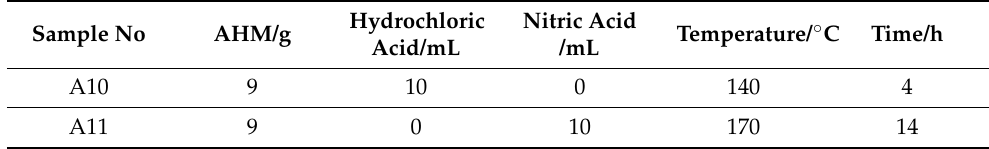
Table 3. Batch formulas of the samples of A10 and A11.